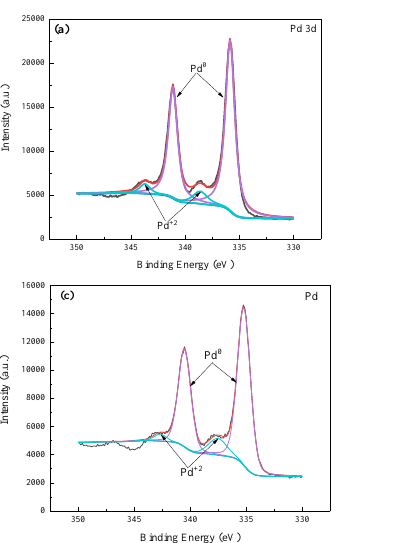
Figure 10. High-resolution XPS spectra of Pd 3d and Sn 3d before and after acceleration process. XPS of Pd 3d ( a ) and Sn 3d ( b ) before acceleration process, and XPS of Pd 3d ( c ) and Sn 3d ( d ) after acceleration process.